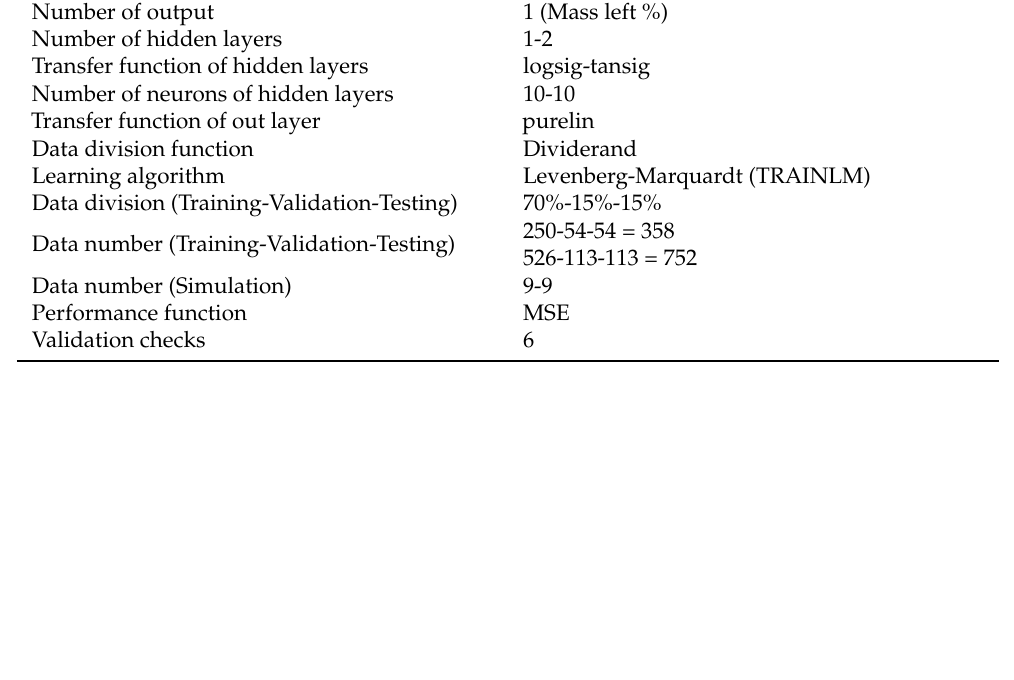
Table 4. Main parameters of the ANN “nntool” model. Number of